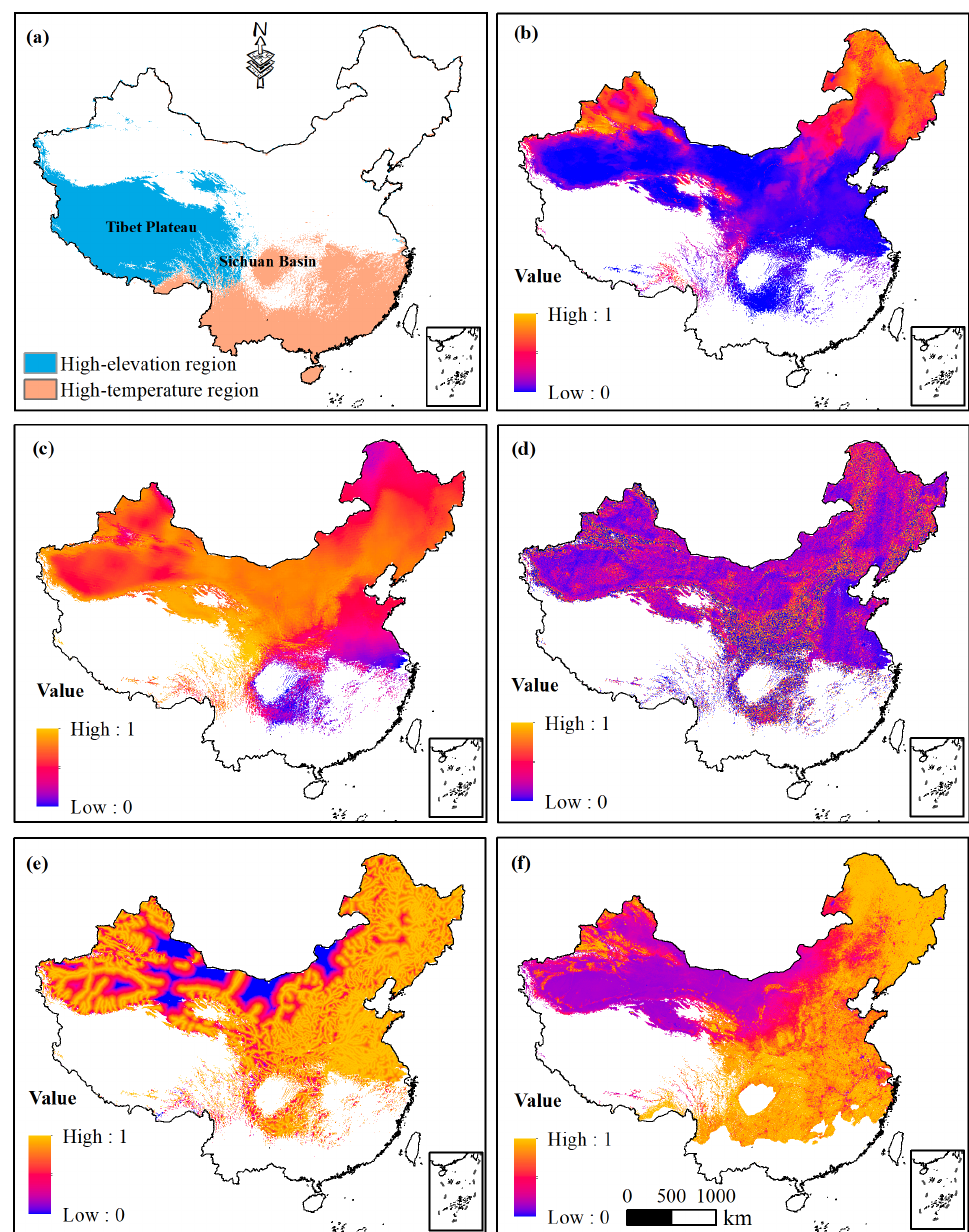
Figure 1. The spatial distribution of the natural condition indexes and excluded